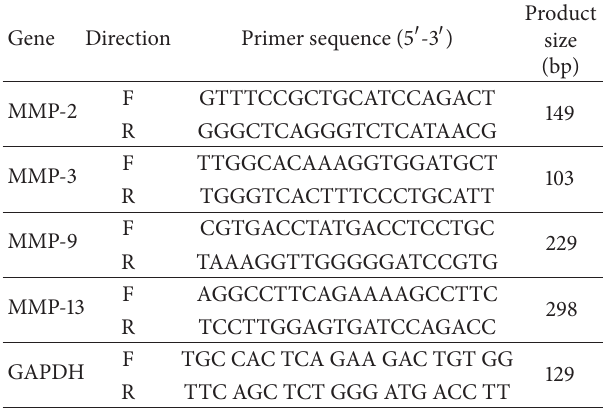
Table 1: Sequences of the primers used in this